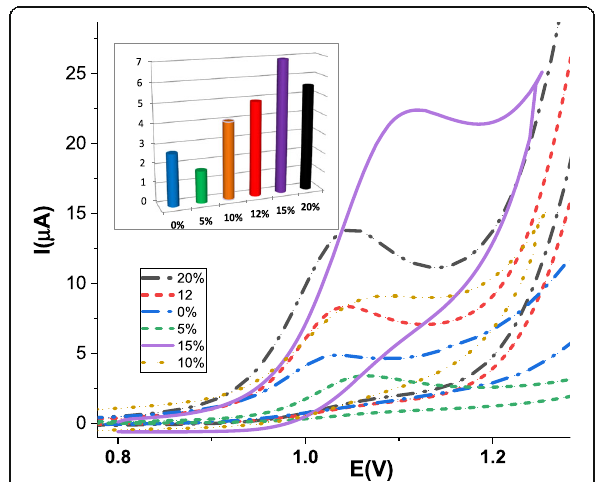
Fig. 5 CV ’ s of 1.0 × 10 − 5 mol L − 1 of LG in BR buffer pH 7.4 at a scan rate of 100 mV s − 1 by different modifier ratios electrodes